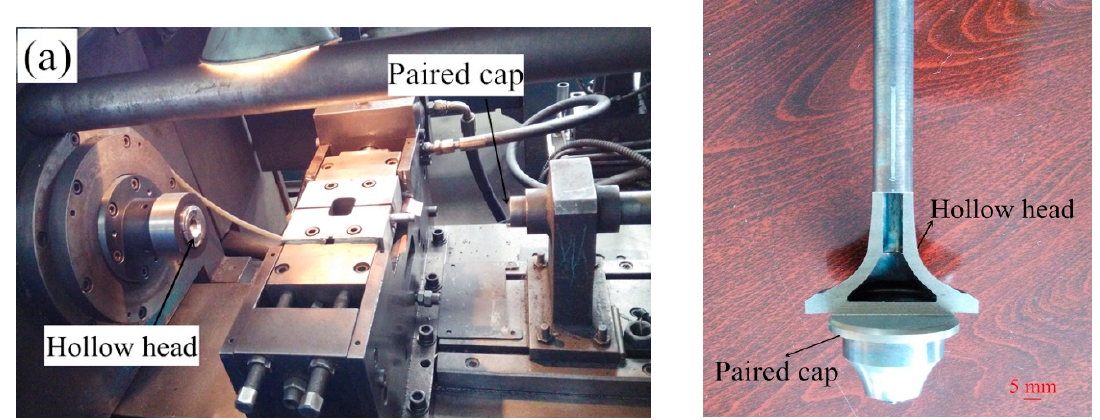
Figure 4. ( a ) Friction welding photo record; ( b ) a typical semi-finished HHSV after welding process.